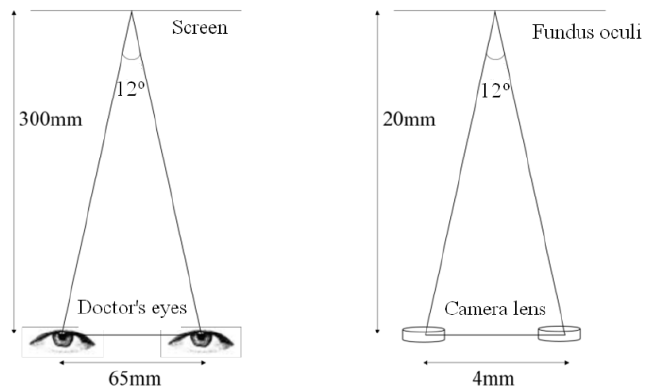
Figure 8. Structural relationship between human eyes and 3D ophthalmoscope glasses.